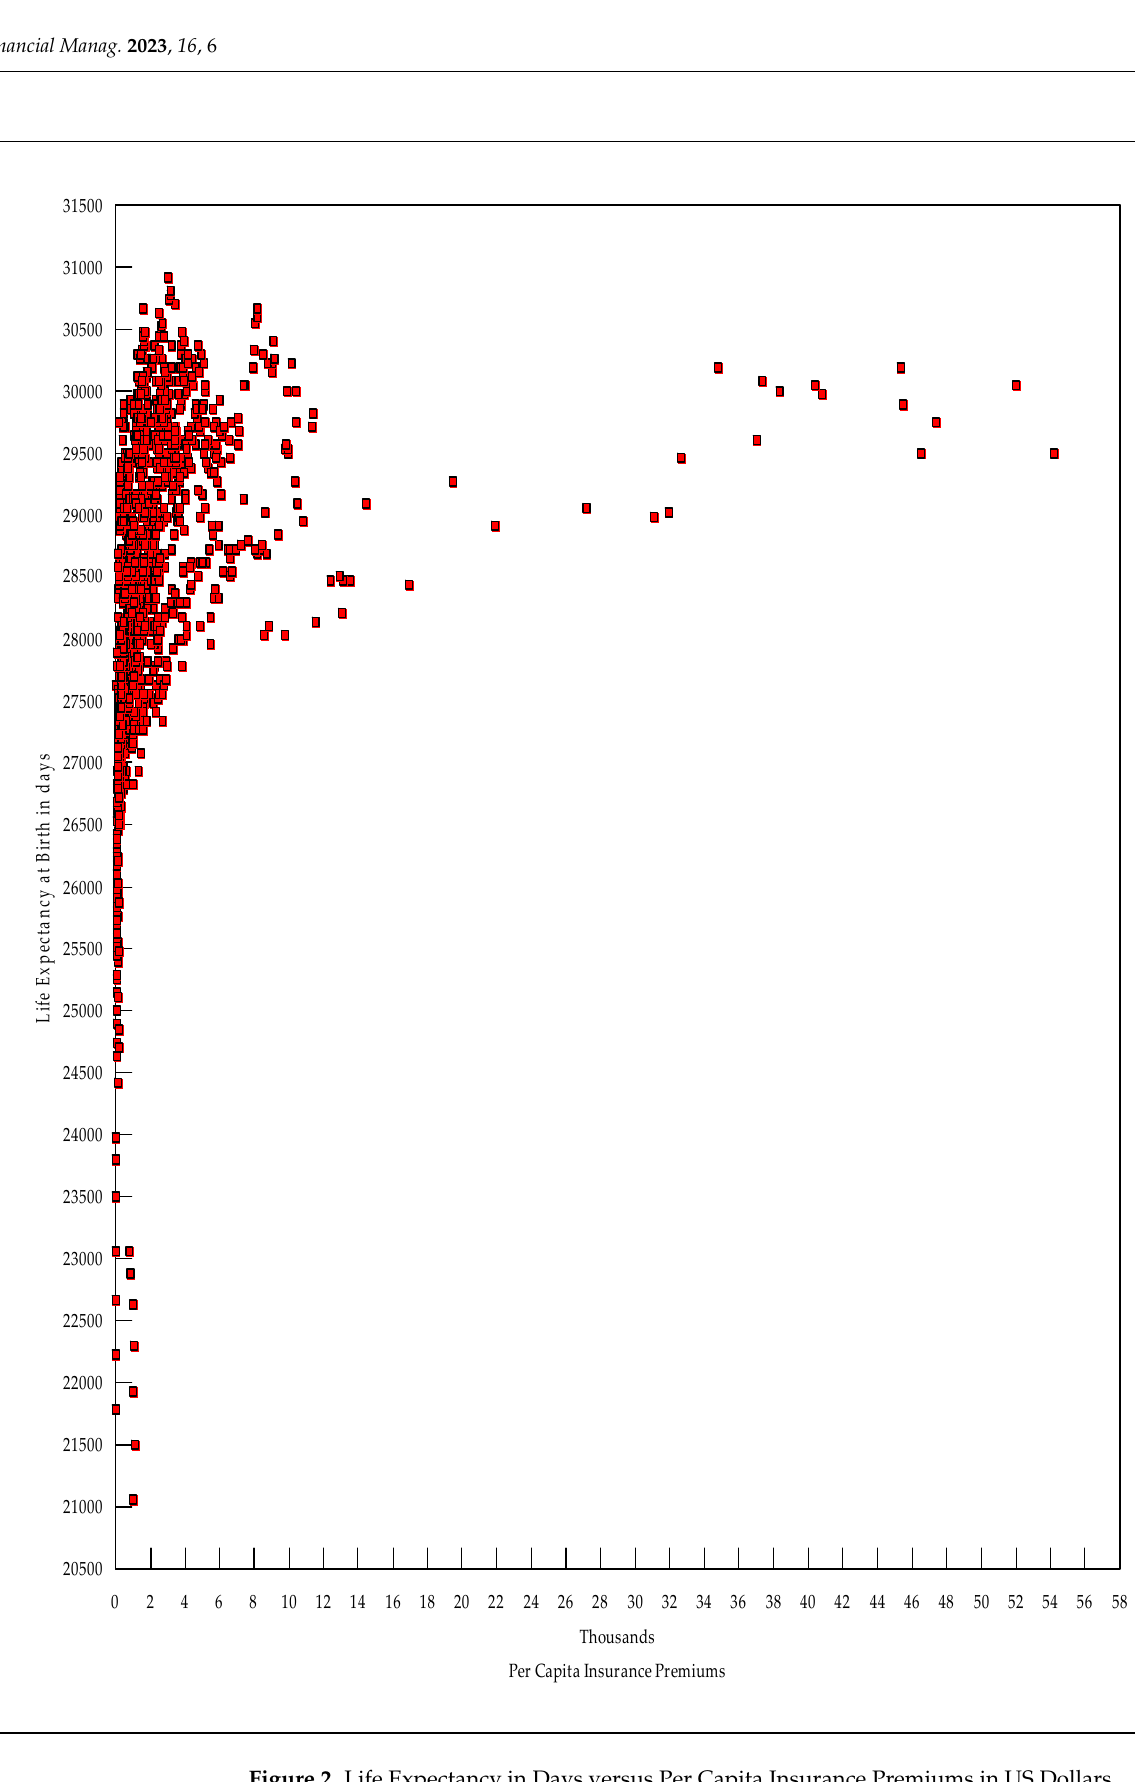
Figure 2. Life Expectancy in Days versus Per Capita Insurance Premiums in US Dollars.